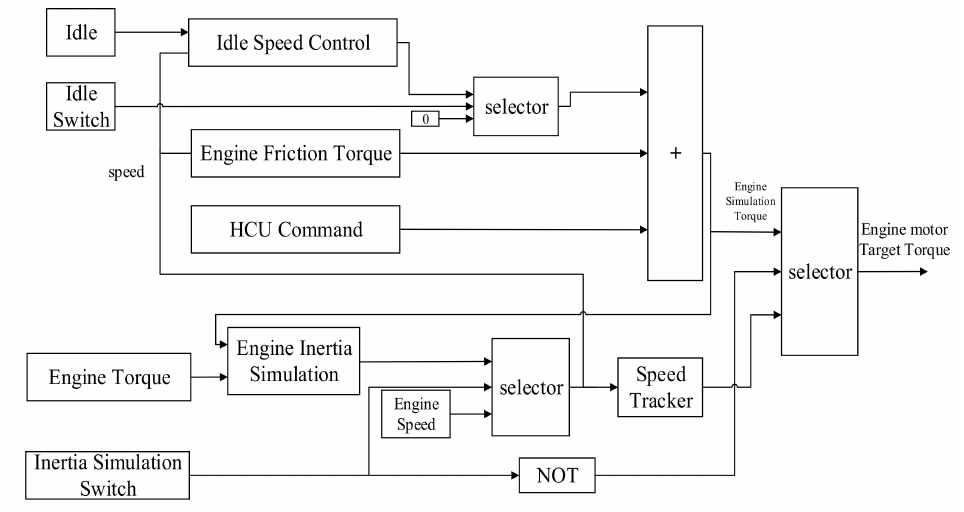
Figure 14. Algorithm of engine simulation.